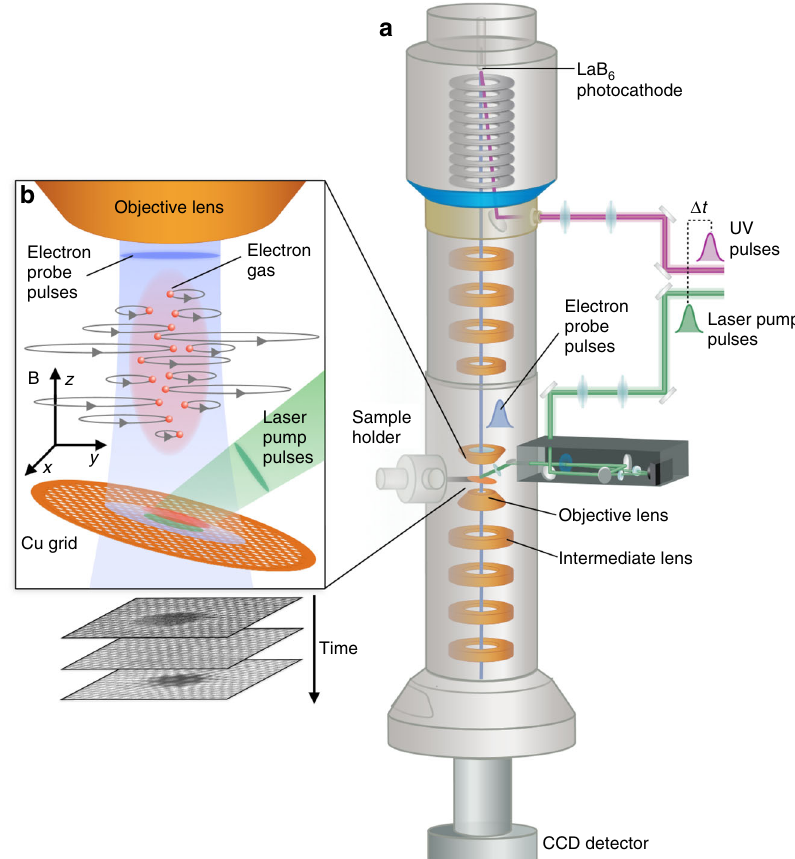
Fig. 1 Schematic of the ultrafast electron microscope used for imaging photoemitted electron gas dynamics. a Short probe electron pulses (~500 fs, 490 kHz, 300 keV) are generated by impinging a UV (256 nm) laser beam onto a LaB 6 photocathode. Pump laser pulses (~200 fs, 528 nm, 490 kHz, ~30 mJ/cm 2 ) are focused onto the Cu grid sample inside a modi fi ed TEM. b A hot electron gas (red), created by means of two-photon emission, acts as a diverging lens to the probe electrons. After initial Coulomb explosion, the electron gas executes cyclotron oscillations (gray orbits) inside the magnetic fi eld ( b ) of the objective lens, which are resolved by changing the relative timing of the pump and probe pulses ( Δ t ). The strength of the intermediate lens in the TEM can be tuned to obtain different imaging conditions. The sample is tilted by 15 o towards the pump laser in order to minimize the laser footprint on the